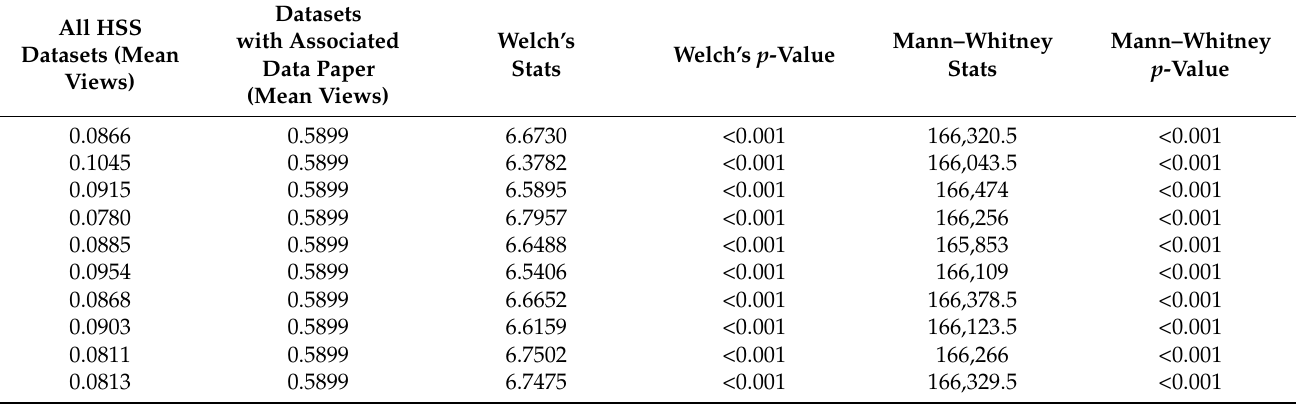
Table 9. Welch’s t -test and Mann–Whitney U -test results: mean views of datasets with an associated data paper and all HSS datasets between 2015 and 2022, at each random sampling of the